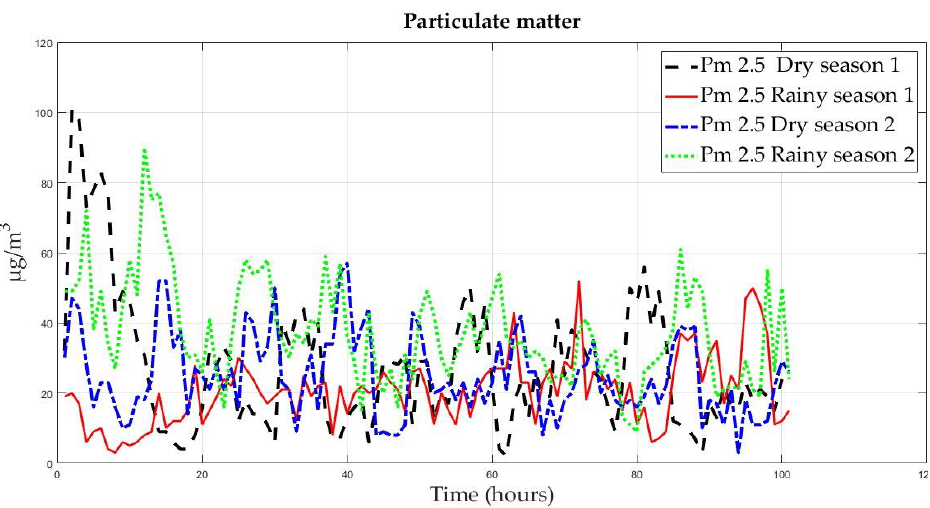
Figure 6. Particulate matter dynamics in different seasons.